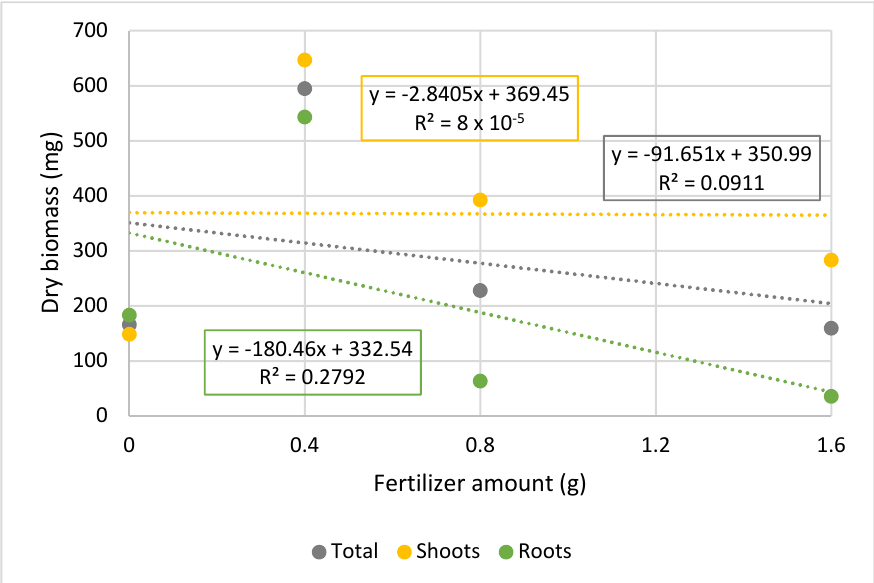
Figure 2. Linear regressions established between the dry biomass of the acclimatized tamarillo plants and the applied CRF doses.